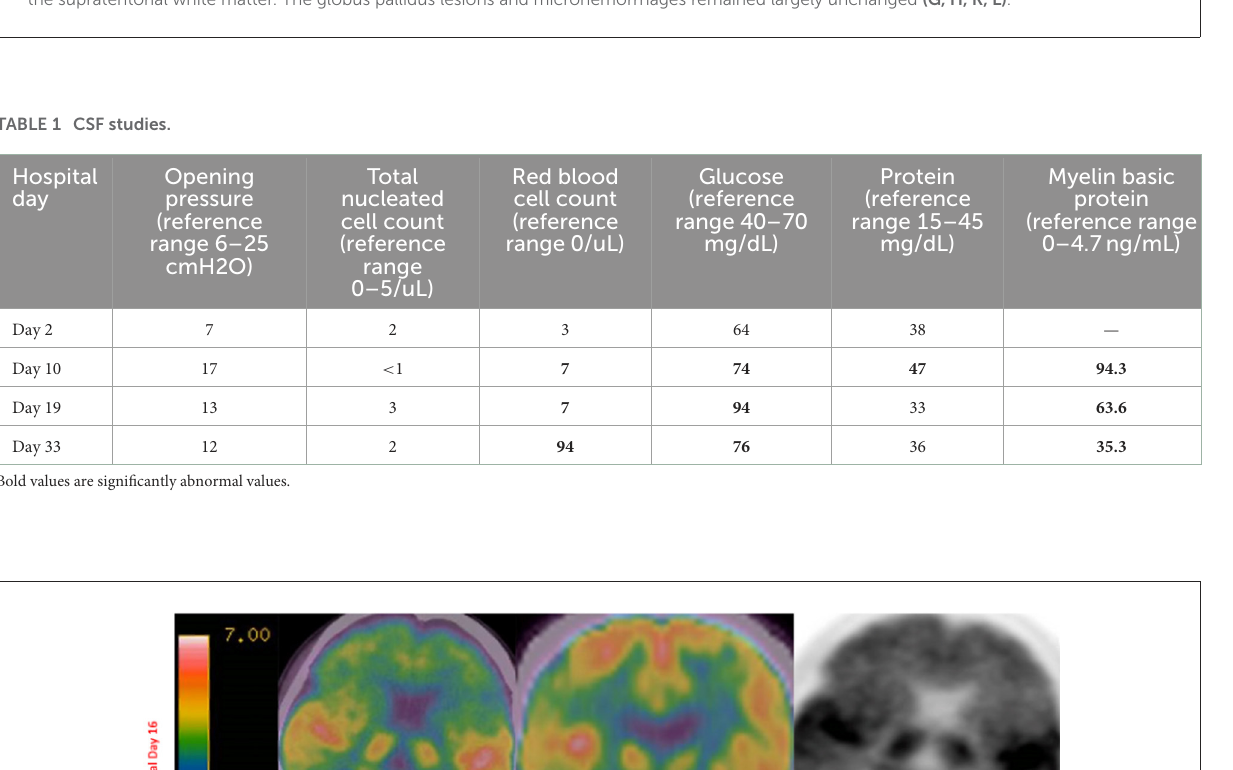
FIGURE1 MR brain on hospital day 1 revealed symmetric bilateral globus pallidus lesions that exhibited T1 and T2 rim hyperintensities (A, B) and contrast enhancement (F) engulfing a T1 and T2 hypointense necrotic core (A, B) . Subtle diffusion restriction of the corona radiata was also demonstrated (C, D) , along with several punctate areas of susceptibility signal loss in the supratentorial white matter indicative of microhemorrhages (E) . Repeat imaging on hospital day 20 revealed significant progression in diffusion restriction (I) with ADC correlate (J) now extensively involving the supratentorial white matter. The globus pallidus lesions and microhemorrhages remained largely unchanged (G, H, K, L) .